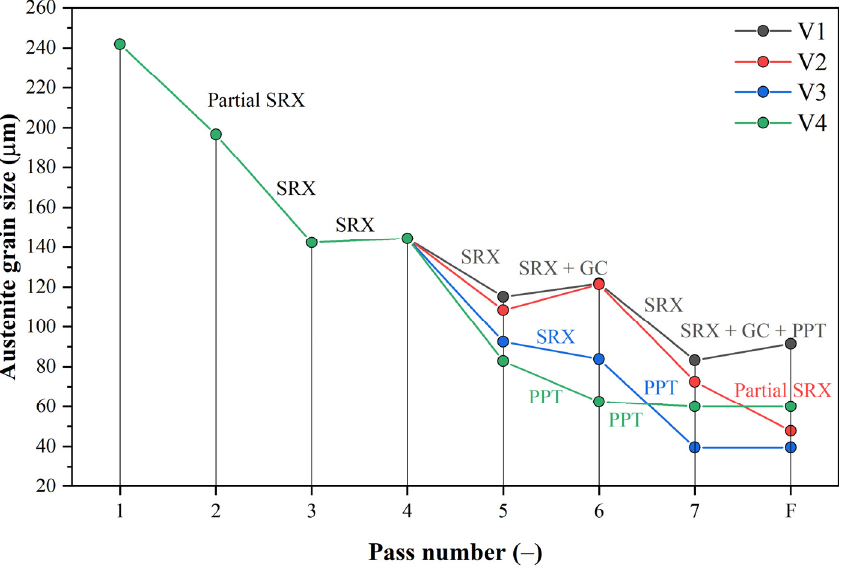
Figure 18. Grain size evolution for all PSCT variants calculated using the modified model.